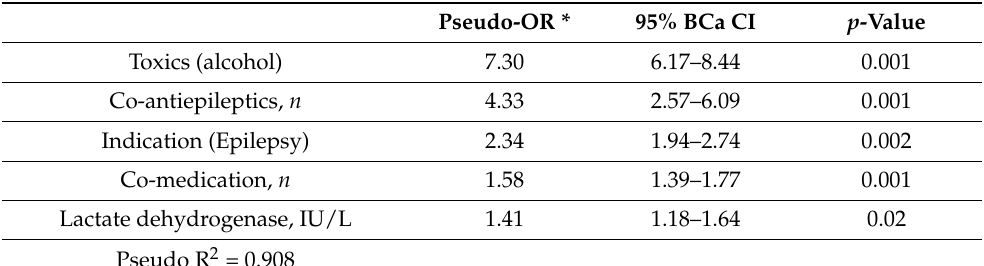
Table 2. Significant factors and covariates in the multiple logistic regression for drug-induced liver